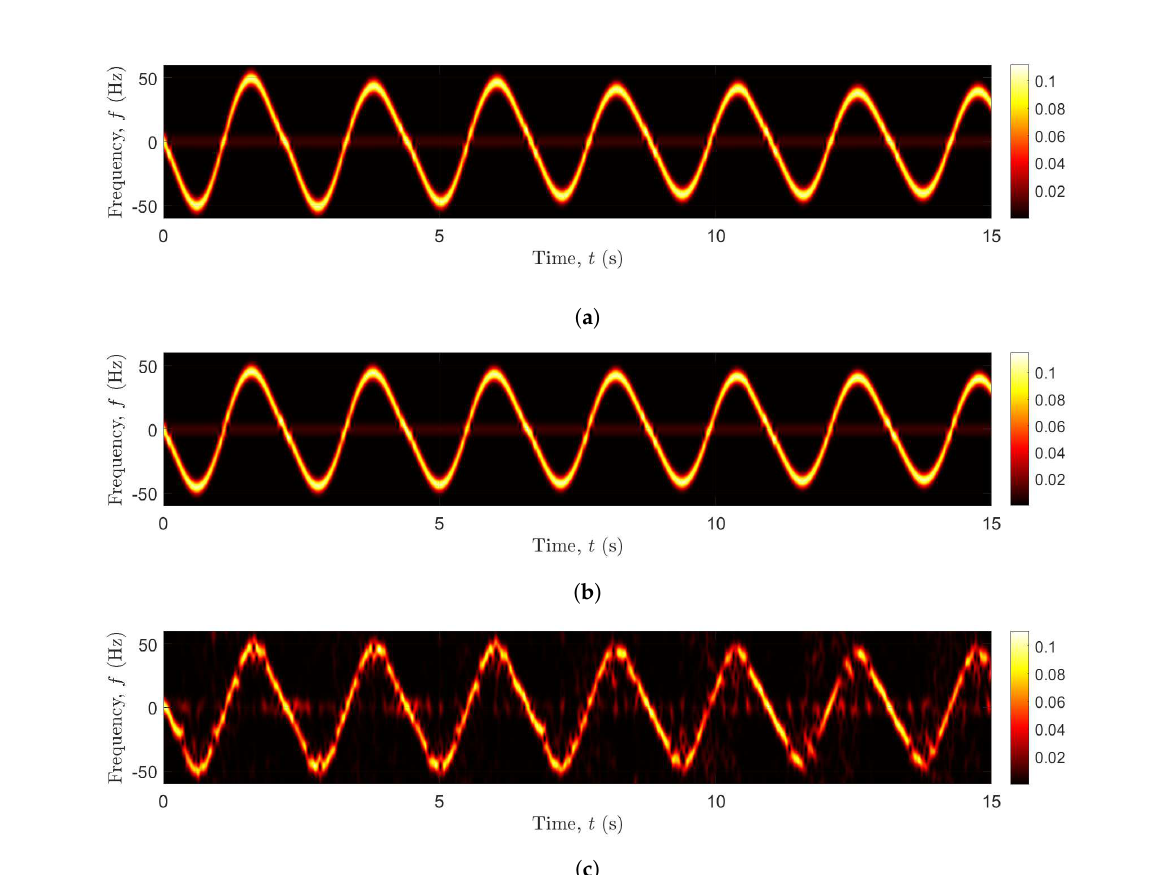
Figure 5. Spectrograms ˜ S ( f , t ) , S ( f , t ) , and ˆ S ( f , t ) ( a ) the channel model with IMU data as inputs, ( b ) the channel model with the mechanical model of the pendulum as inputs, and ( c ) measured CSI, respectively.